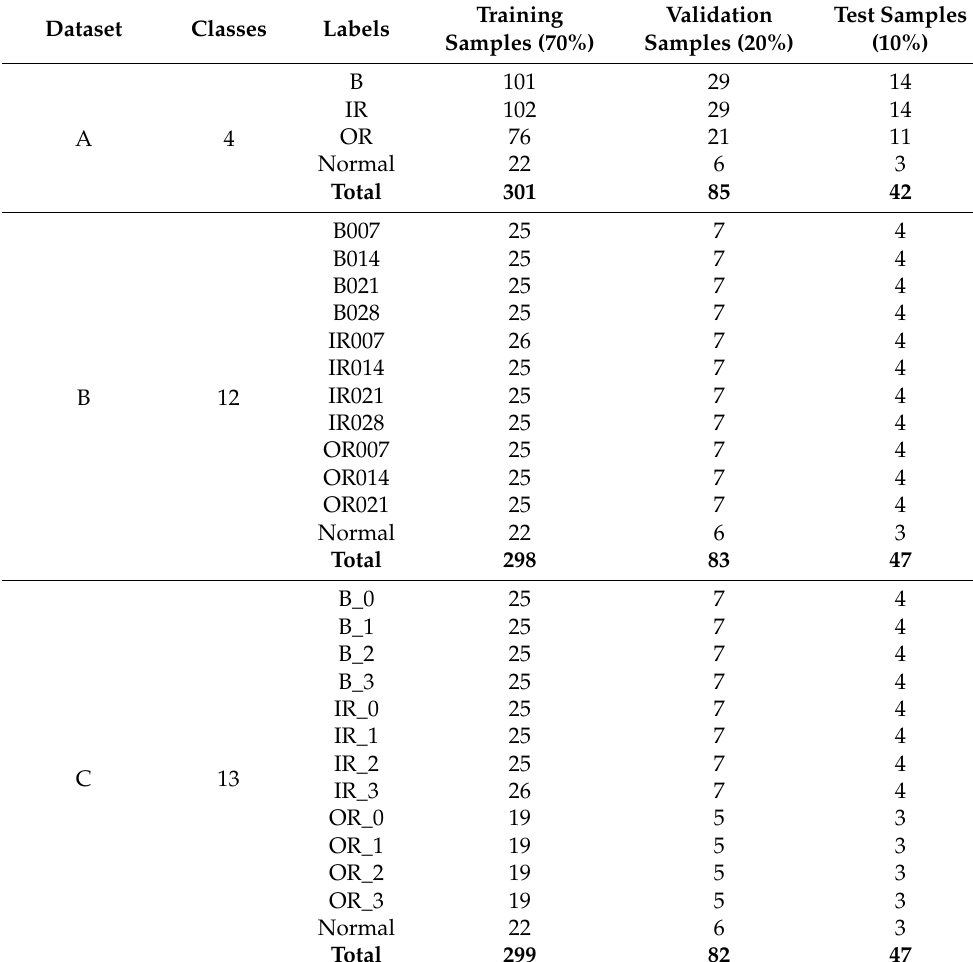
Table 1. Dataset split.